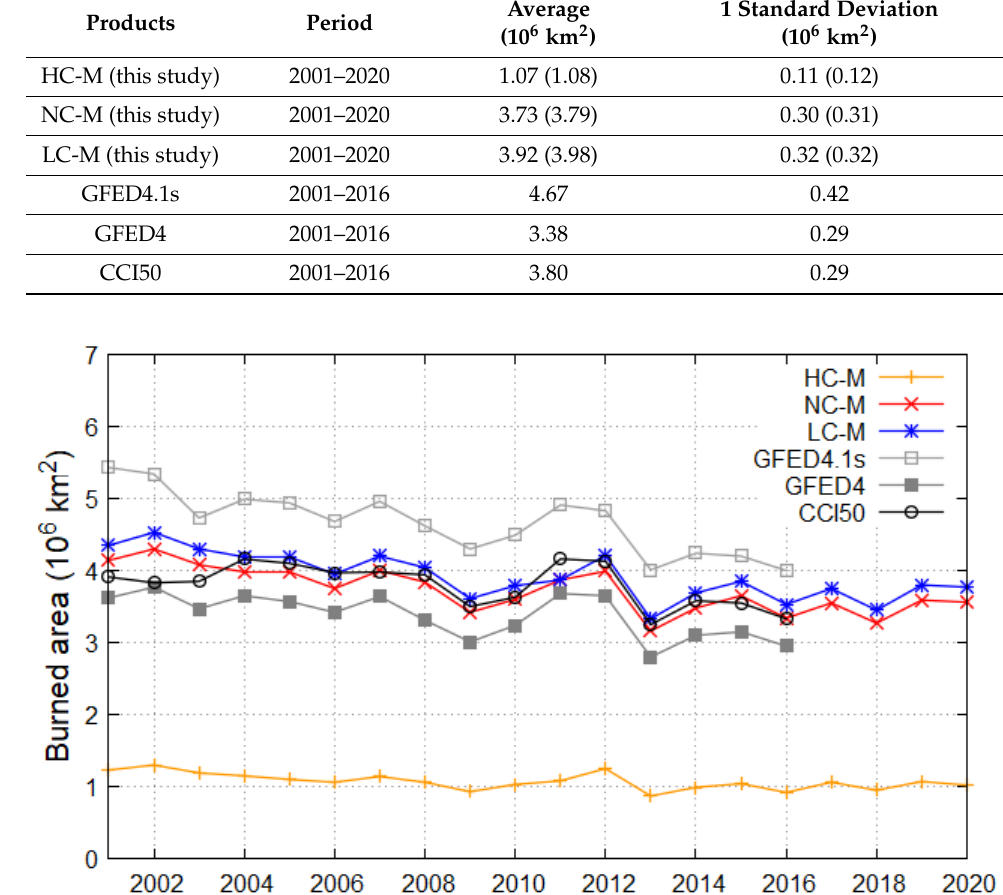
Figure 2. Interannual variation in the global burned area of the three maps of this study (HC ‐ M, NC ‐ M, and LC ‐ M) and previous studies (GFED4, GFED4.1s, and CCI50) between 2001 and 2020.